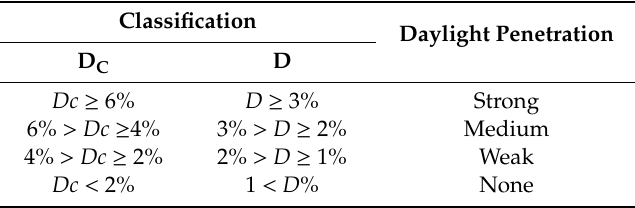
Table 3. Daylight penetration as function of the daylight factor D C for the carcass façade opening and daylight factor D for the zone, according to EN 15193 1: 2017-08 [18].